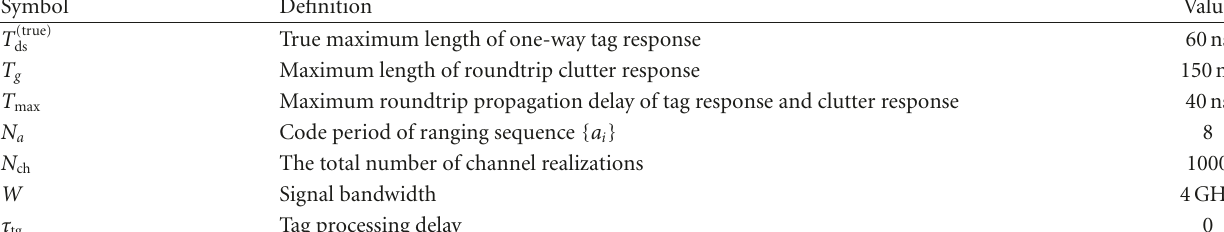
Table 1: Summary of Adopted Symbols for Simulation.